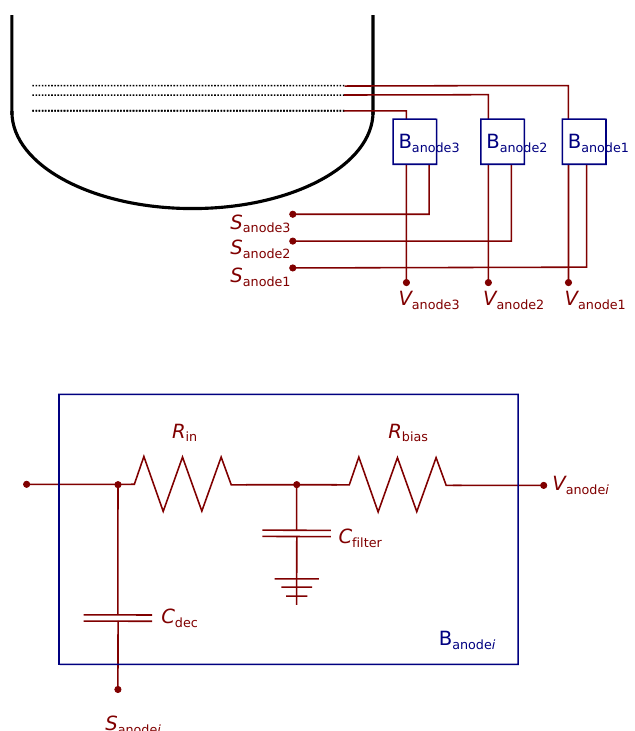
Figure 7. Schematic of the circuit to bring high voltage ( V anode i , i ∈ 1,2,3) to the anode meshes and decouple the signal from the high voltage lines. The signals are decoupled in bias boxes via a 10nF decoupling capacitor ( C dec ) and are then fed to the signal line ( S anode i ). These bias boxes B anode i also feature a protection and filtering circuit consisting of a bias resistor ( R bias = 200M Ω ), filter capacitor ( C filter = 10nF), and input resistor at the detector input ( R in =10M Ω